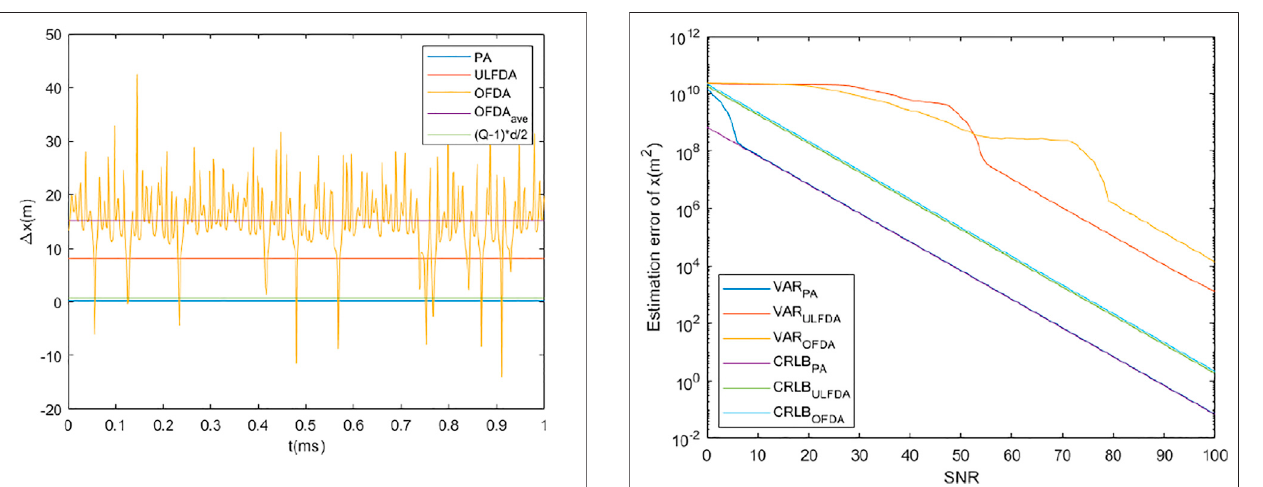
FIGURE 7 | The Difference of Arrival deception effect of the OFDA.